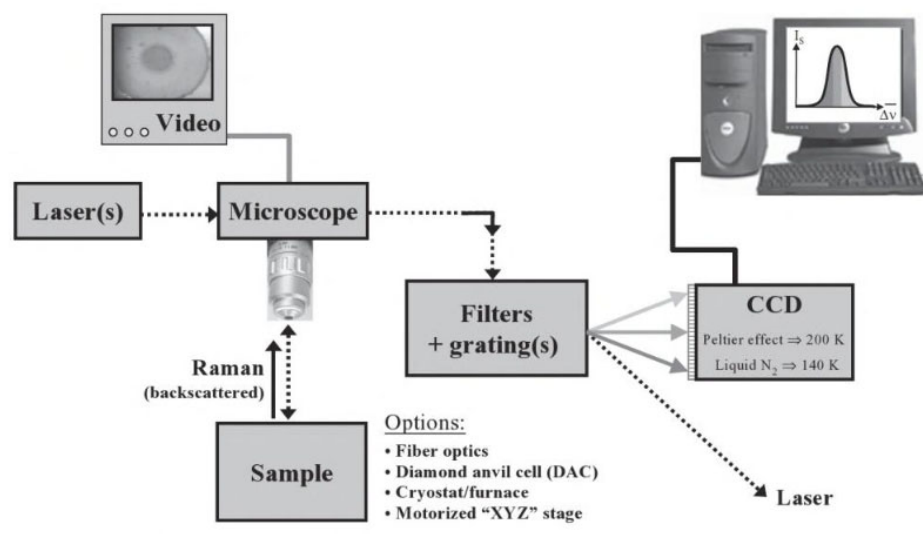
Figure 22. Components of Raman spectroscopy instrumentation [103].